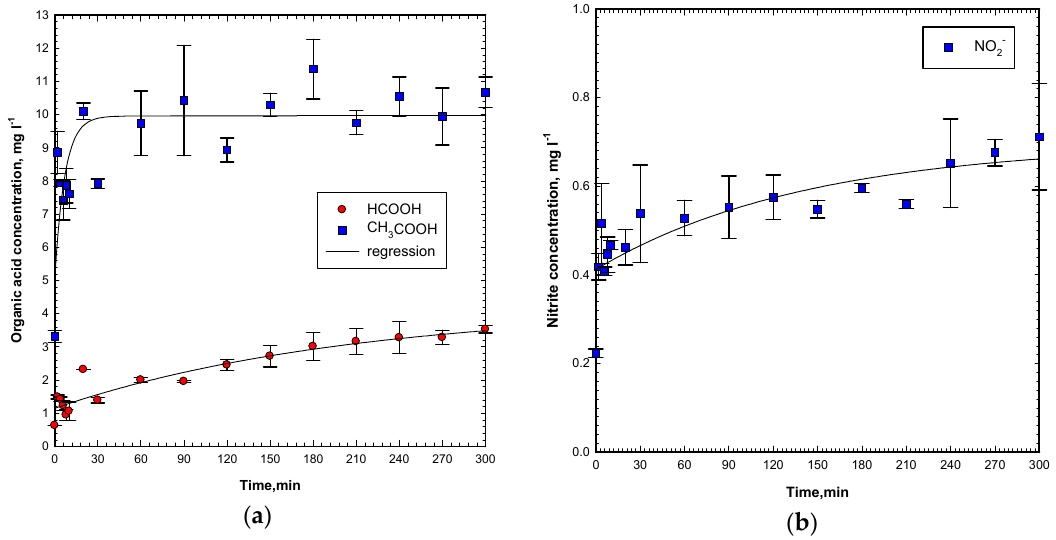
Figure 11. The mineralization products, ( a ) organic acids and ( b ) nitrite, formed under the Vis/ZnO process. The operating conditions were initial OG concentration of 50 mg L − 1 , ZnO dosage of 60 g m − 2 , visible light intensity of 9600 Lux, and a reaction time duration of 300 min.